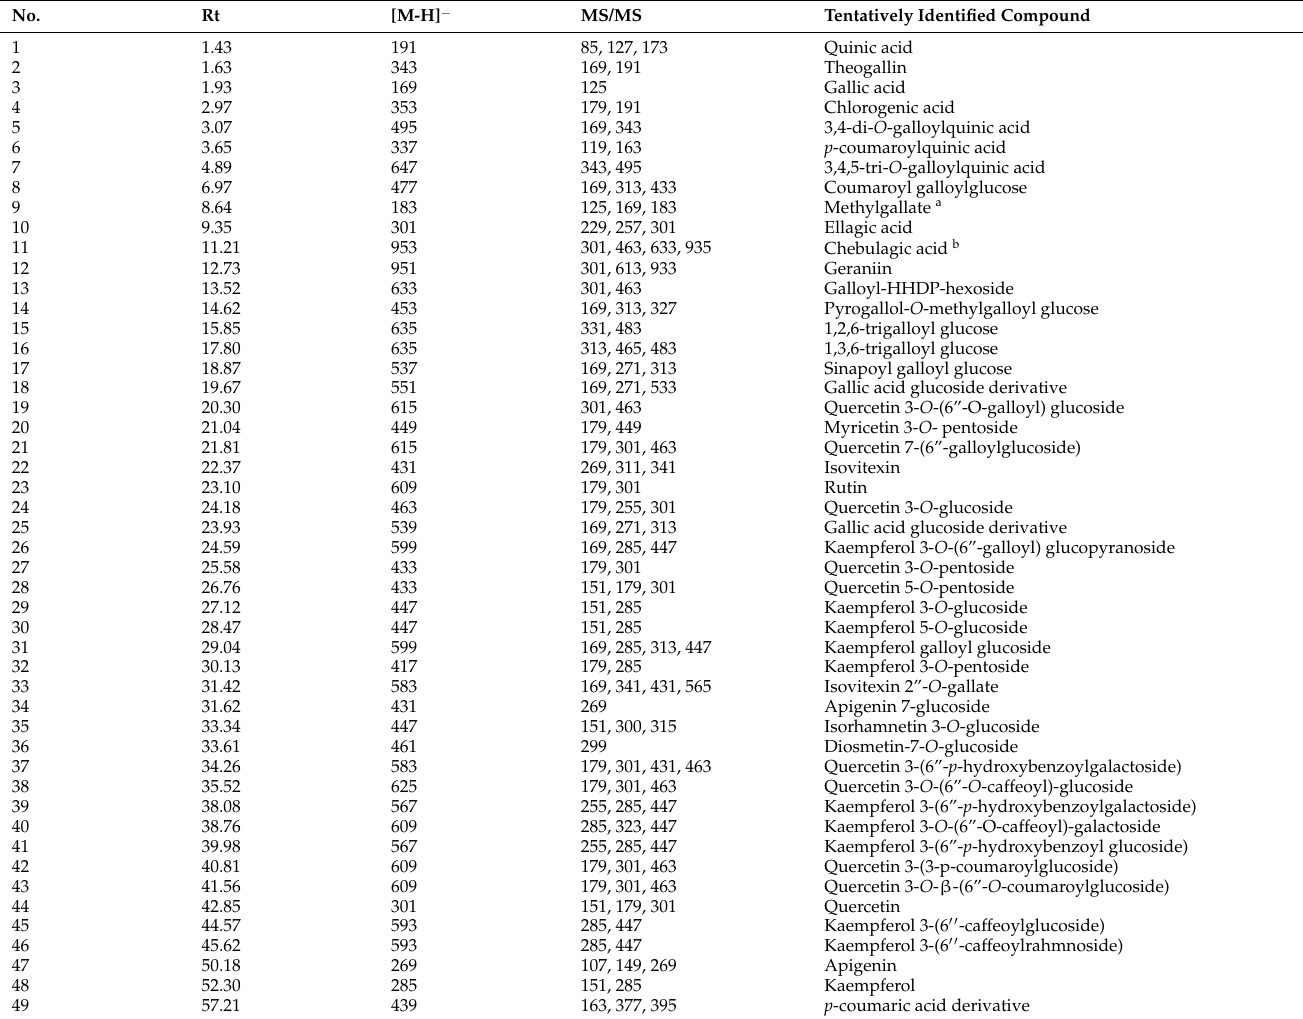
Table 2. Analysis of secondary metabolites from H. abyssinica leaves utilizing LC-MS/MS.